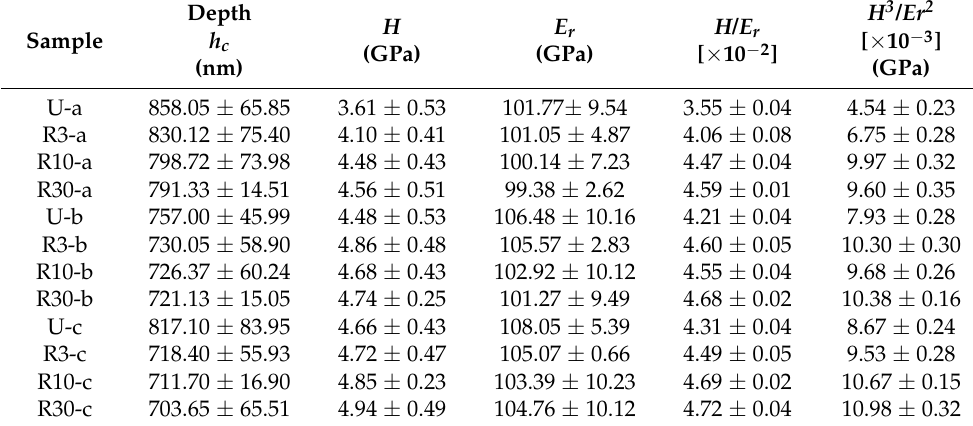
Table 2. Nanoindentation values for the set of the experimental sintering process.